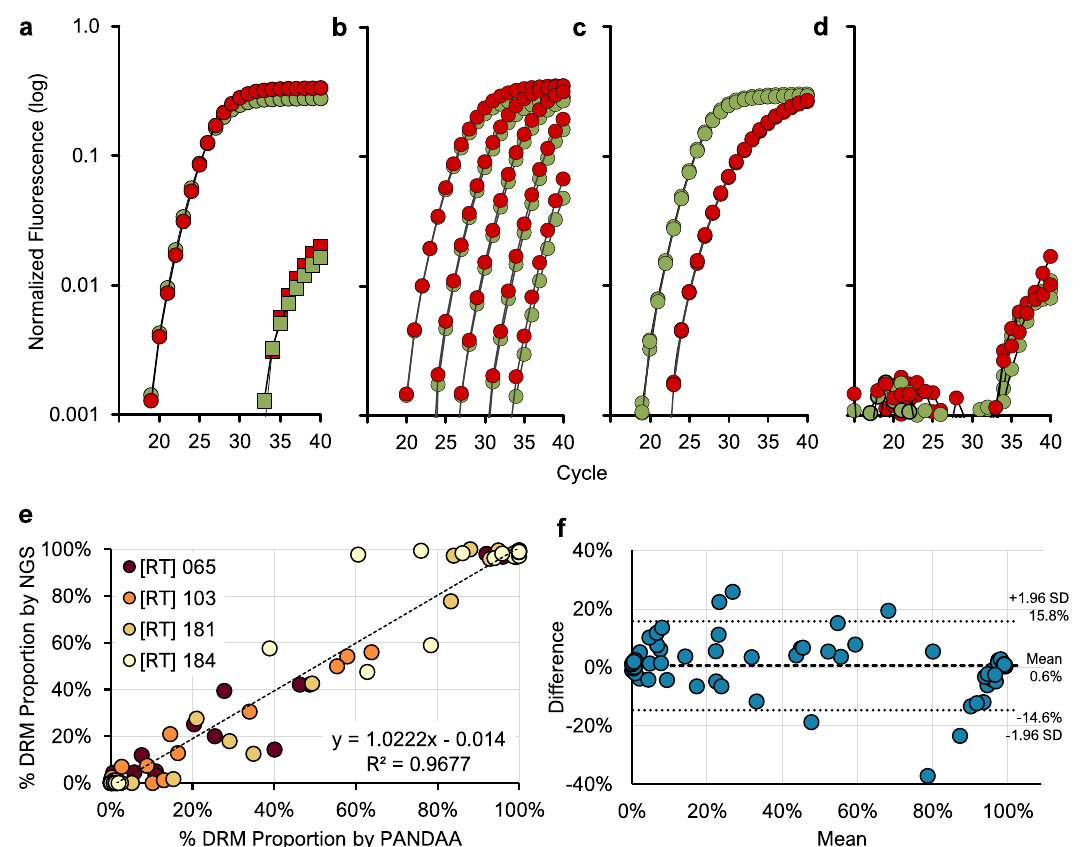
Fig. 5 Validation of PANDAA performance. PANDAA with differentially labeled TaqMan probes to discriminate wild-type DNA (VIC-labeled [green]) from the K103N DRM (FAM-labeled [red]). a Using either 100% wild-type DNA or 100% mutant 014 template DNA at 10 5 copies per reaction, non- speci fi c DRM signal (red squares) can clearly be differentiated from the speci fi c wild-type signal (green circles) in wild-type only reactions. Similarly, the non-speci fi c wild-type signal (green squares) are distinguishable from the speci fi c K103 DRM signal (red circles). b PANDAA on 10-fold dilutions of a 1:1 mixture of 10 5 to 10 total DNA copies; thus, wild-type (green circles) and mutant DNA (red circles) were present at 50% of those quantities. c Mixed populations of wild-type (green) to mutant DNA (red), representing 10% K103N DRM at 10 5 total copies of DNA. d Negative control using human genomic DNA. Results are representative of a minimum of six replicates of each dilution series. The x -axis represents the number of qPCR cycles and the y-axis represents the log normalized fl uorescence. e Correlation of PANDAA with NGS. Pearson ’ s correlation coef fi cient showed a strong agreement between the K65, K103N, Y181C, and M184VI DRM proportions quanti fi ed by PANDAA and those quanti fi ed by NGS ( r = 0.9837; 95% CI: 0.9759 – 0.9890; P < 0.0001). f A Bland – Altman plot of the agreement between DRM quanti fi cation by PANDAA and NGS shows a mean bias of 0.6% (±7.8%) with 95% limits of agreement (dotted lines) ranging from − 14.6% to